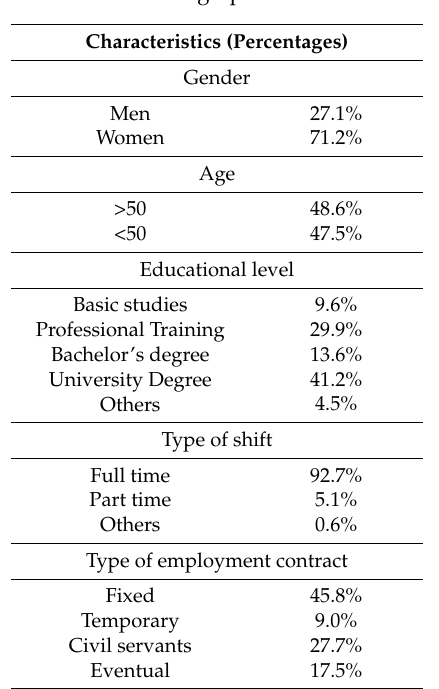
Table 1. Sociodemographic